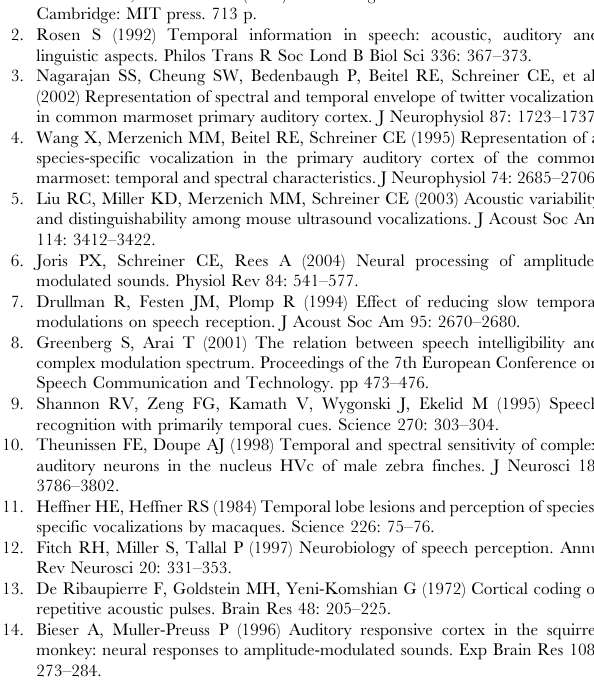
Figure S2 An example of ISI histograms for six different repetition rates from one site. There is no additional peak corresponding to the period of the stimulus repetition rates. This site is a less common example. VS information: 0.01 bits/stimulus.